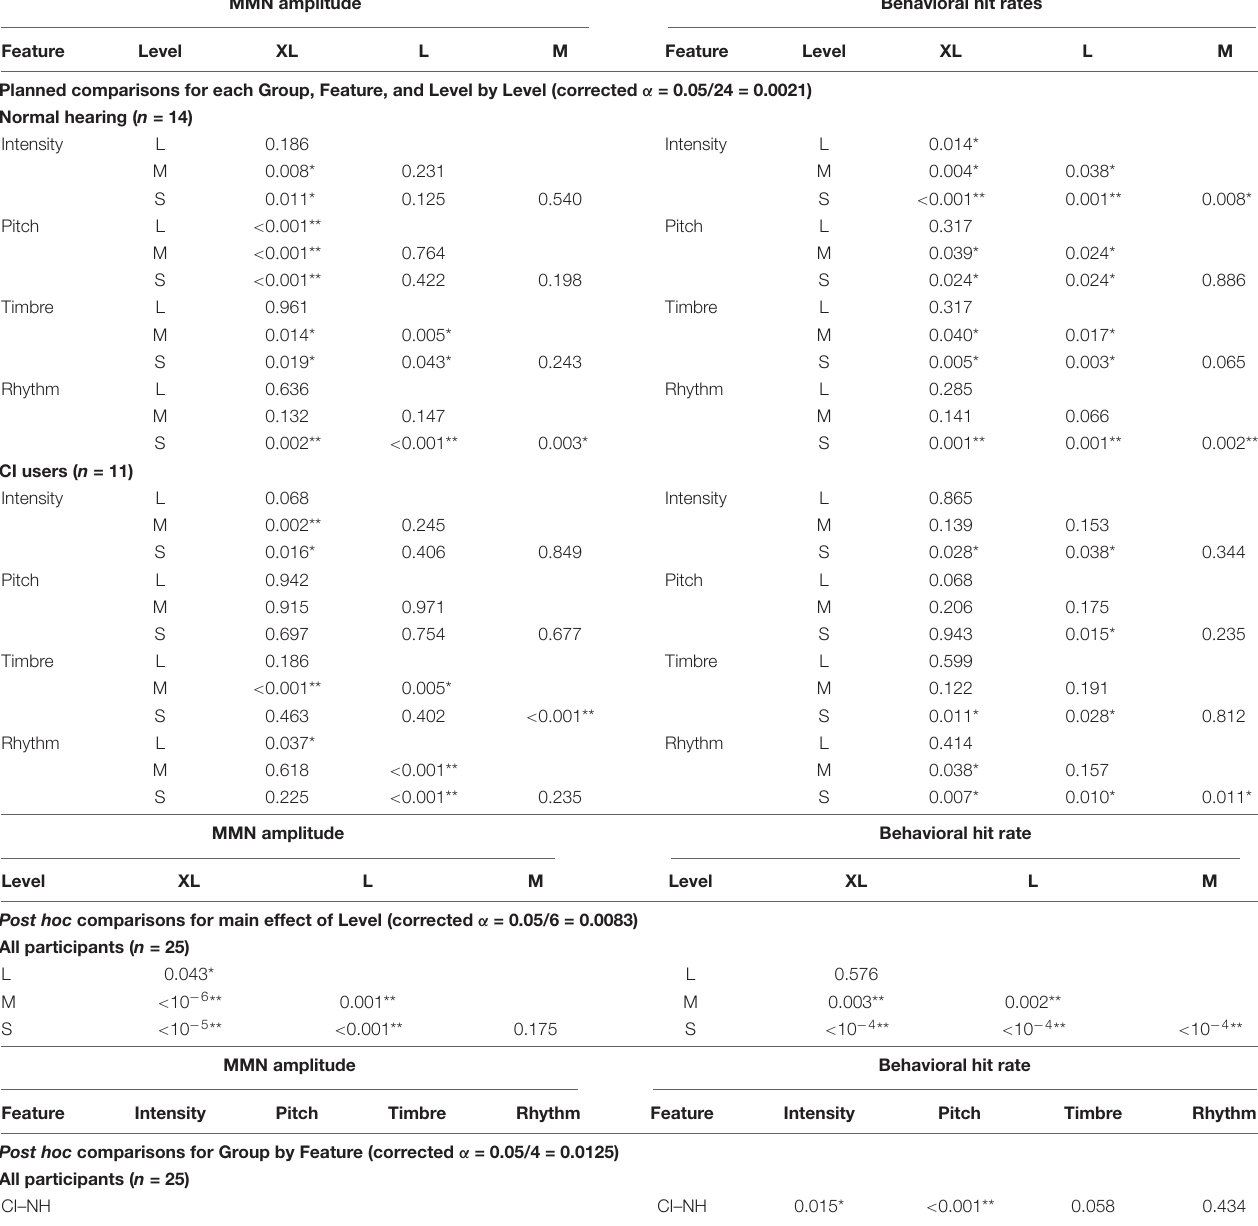
TABLE 4 | Post hoc